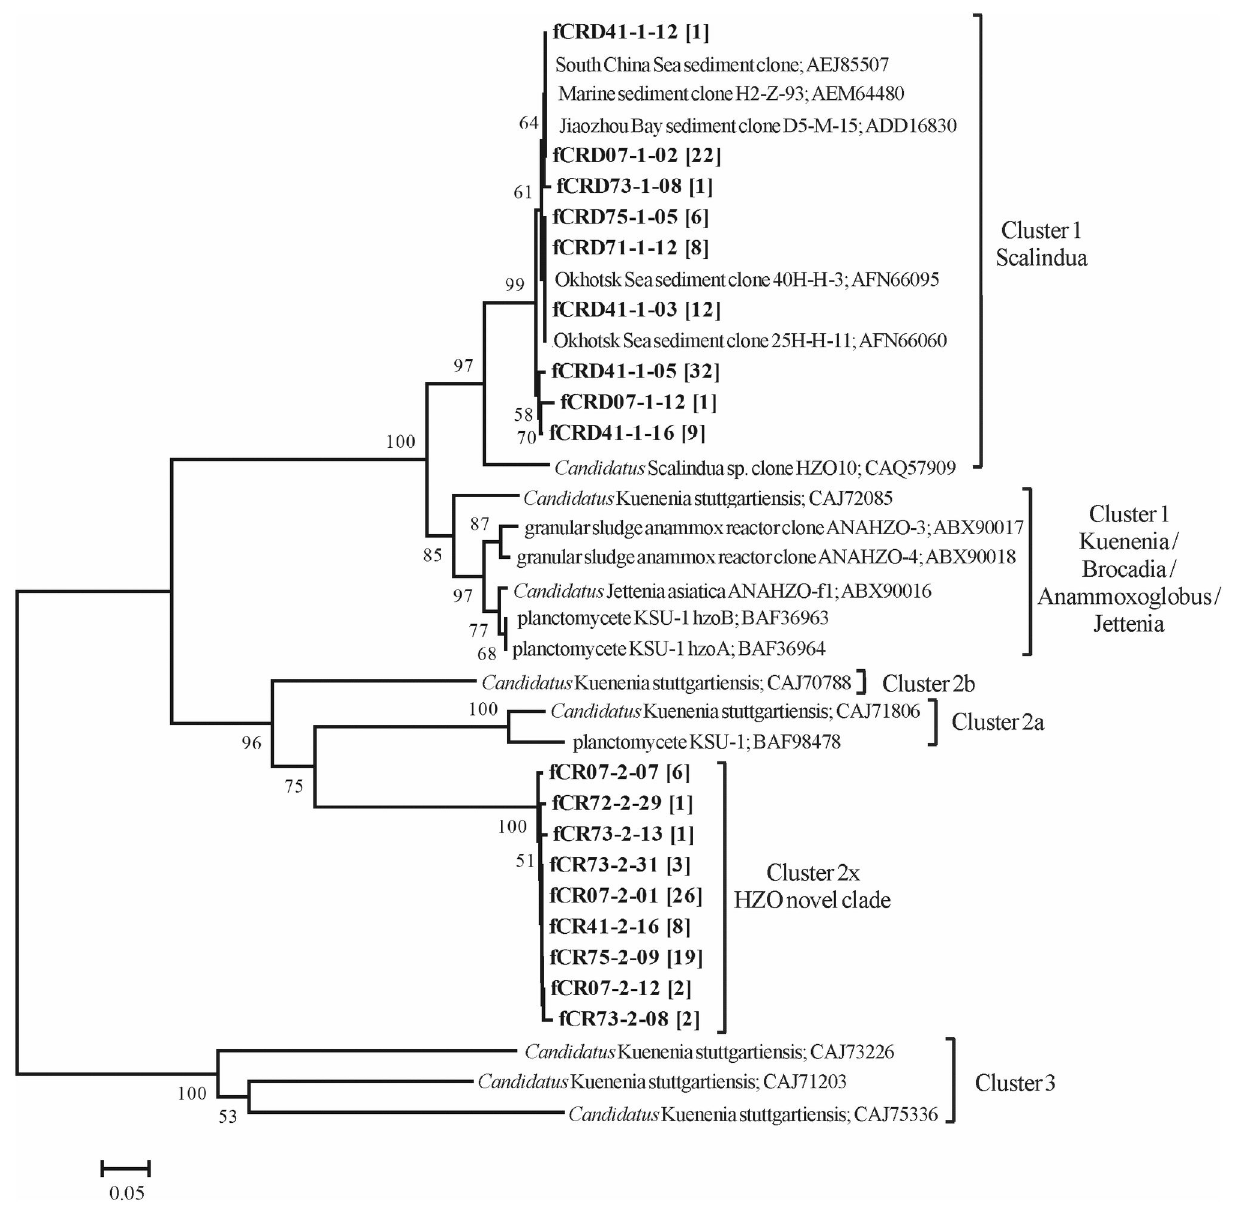
Figure 4. Neighbor-joining phylogenetic tree constructed with anammox bacteria hzo -deduced amino acid sequences from the oxygen minimum zone (OMZ) in Costa Rica Dome (CRD). The sequences in bold were obtained in the present study. The sequences were grouped at a 1% cutoff value using DOTUR and only one sequence was selected to represent the operational taxonomic unit (OTU). The number in the brackets followed the sequence name indicated the number of the clones recovered. Bootstrap resampling was performed 1000 times and only its values higher than 50% are shown. The scale bar presents the number of amino acid substitutions per